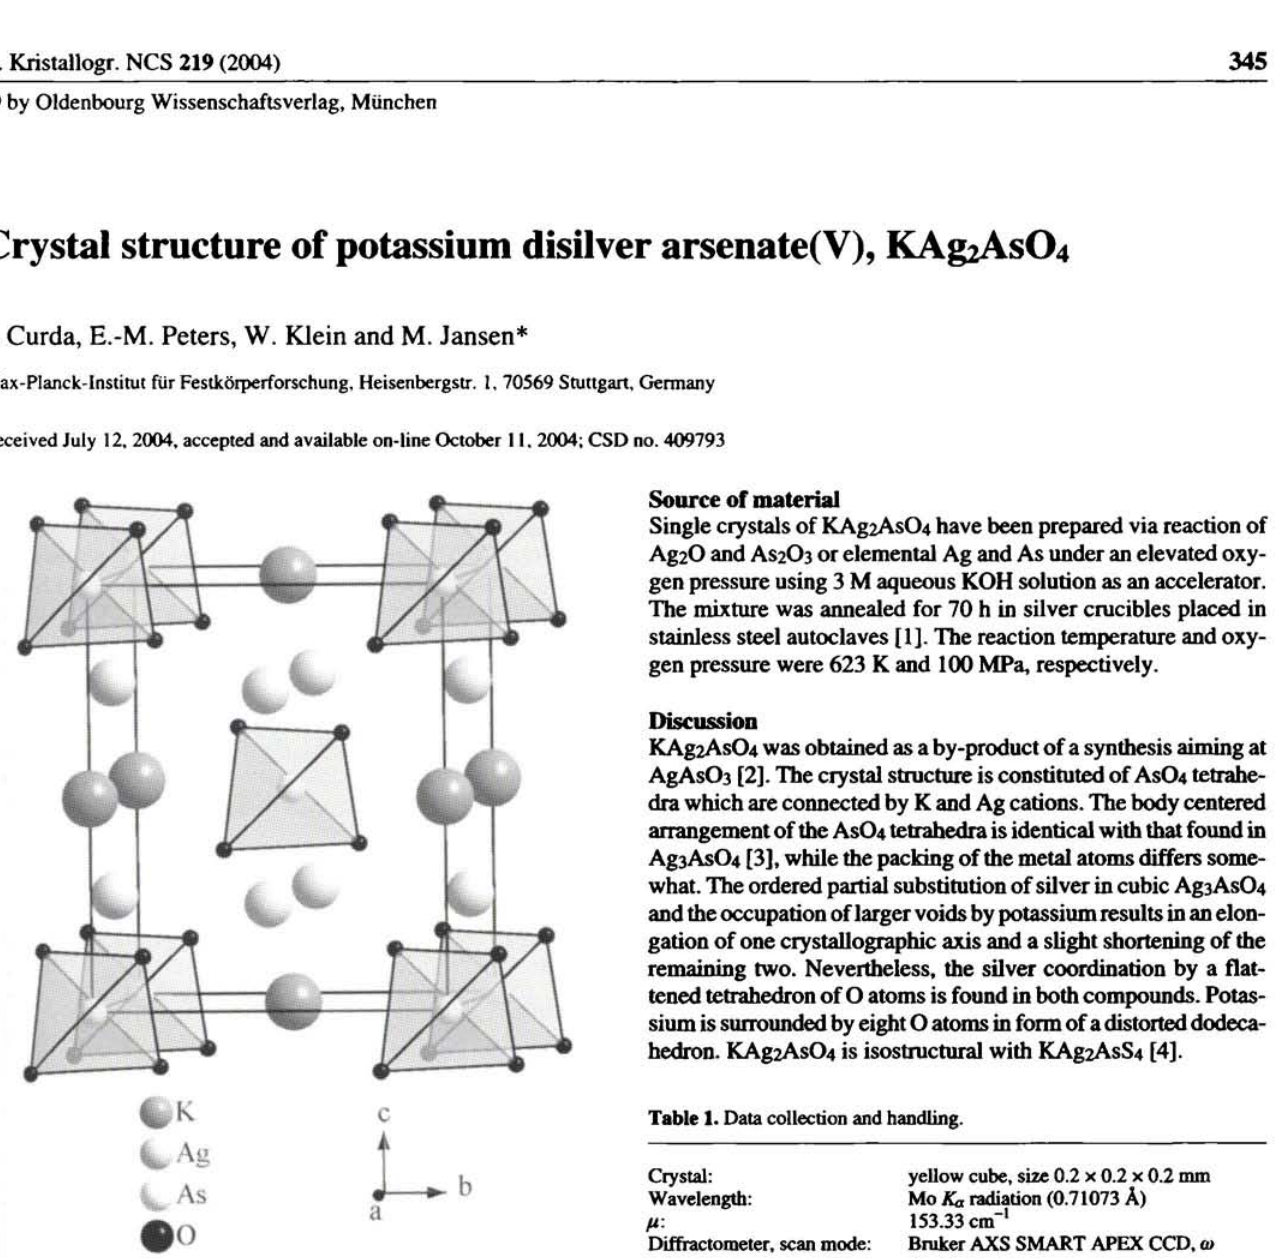
Table 2. Atomic coordinates and displacement parameters (in A 2